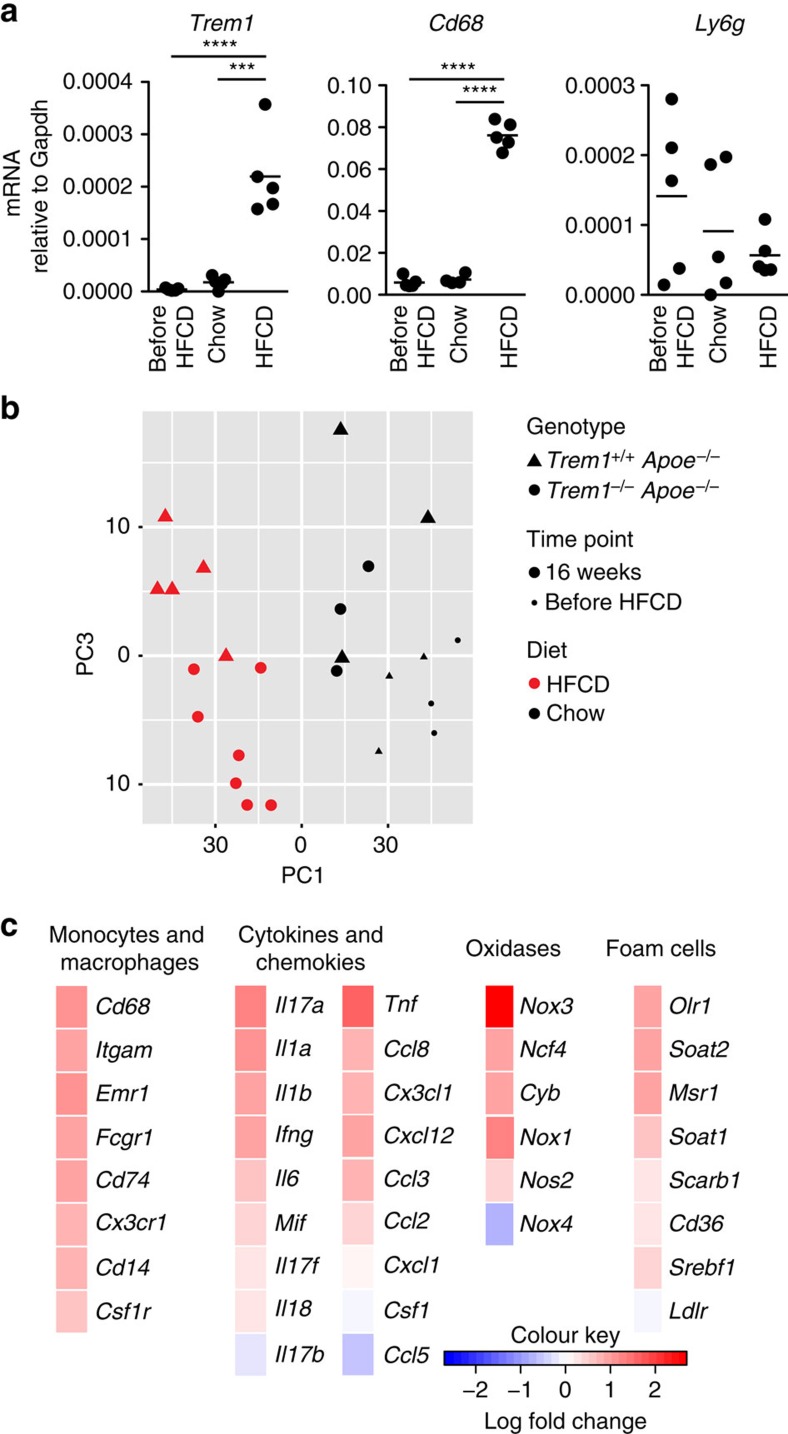
Trem1 is expressed in situ and associates with increased macrophage accumulation.(a) Trem1, Cd68 and Ly6g mRNA expression in the aortic arch of Trem1+/+
Apoe−/− mice before the start of diet (before HFCD) and at 16 weeks post chow or HFCD feeding was determined by qRT-PCR and normalized to the expression of Gapdh. ***P<0.001, ****P<0.0001. (b,c) RNA isolated from the aortic arch of Trem1+/+
Apoe−/− and Trem1−/−
Apoe−/− mice before HFCD (n=3 per group) or at 16 weeks post chow (n=3 per group) or post HFCD feeding (n=5 and 7) was subjected to Nanostring nCounter-based quantification of gene expression. (b) PCA analysis. Each symbol represents an individual mouse. (c) Heat-maps of selected gene groups. Mean log fold changes in gene expression in the aortic arch of 16-week HFCD-fed Trem1+/+
Apoe−/− (n=5) over Trem1−/−
Apoe−/− (n=7) mice are shown. PCA, principle component analysis.